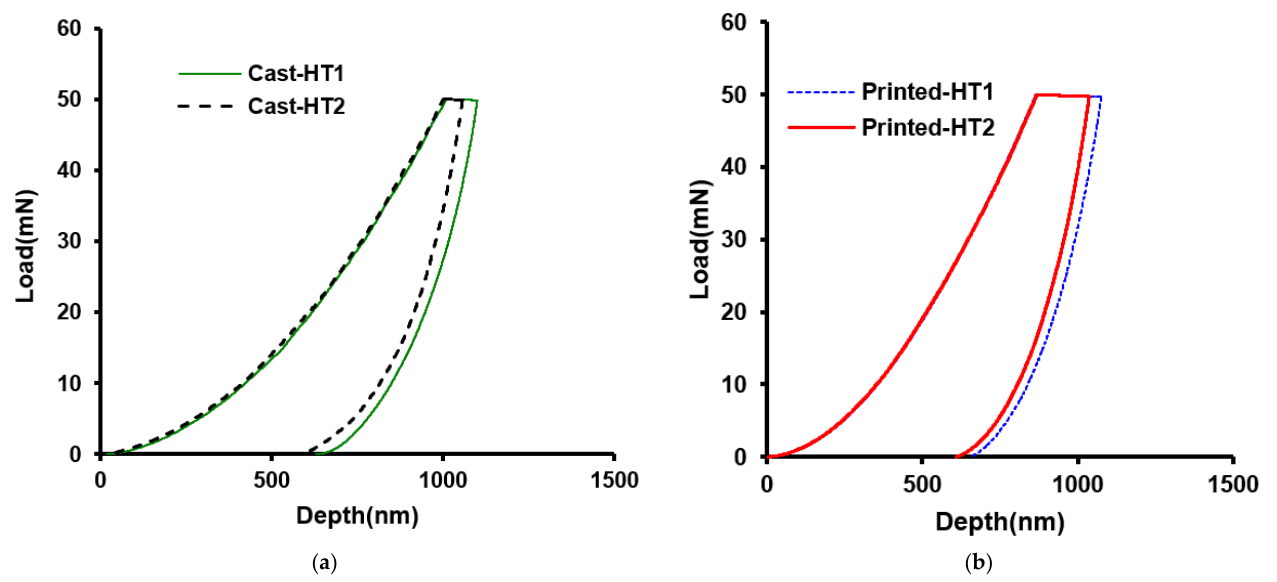
Figure 5. Typical P ‐ h curves of NiTi samples at 50 mN: ( a ) two heat ‐ treated samples in cast condition; ( b ) two heat ‐ treated Figure 5. Typical P-h curves of NiTi samples at 50 mN: ( a ) two heat-treated samples in cast condition; ( b ) two heat-treated samples in printed condition. samples in printed Table 4. Hardness and modulus of elasticity values.